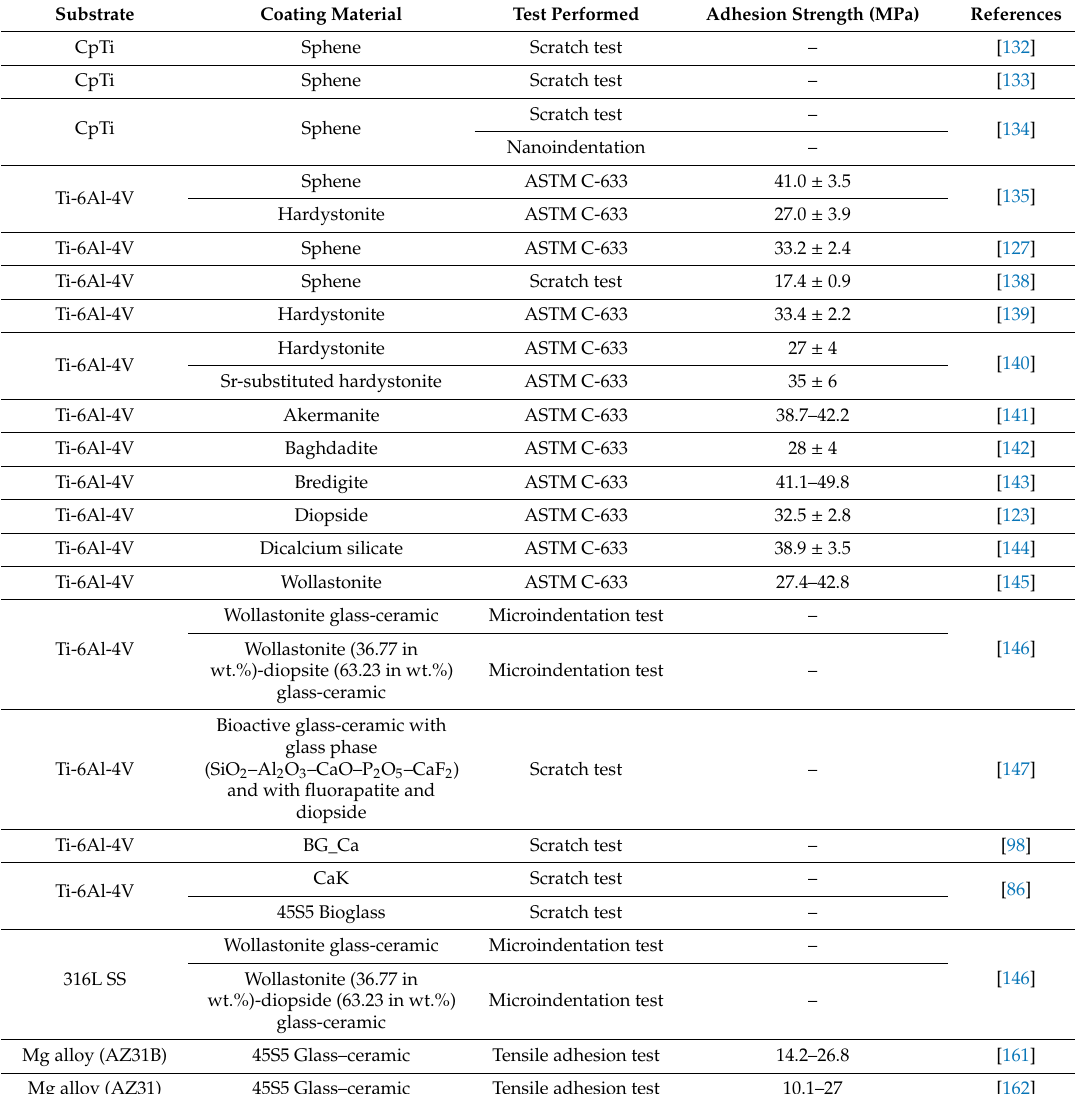
Table 5. Coating-substrate adhesion